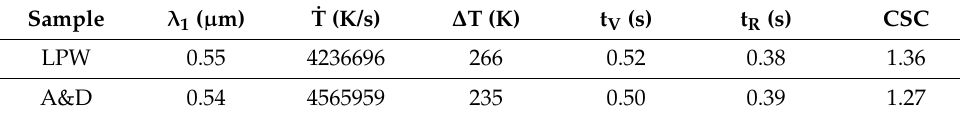
Figure 14. Curves obtained following Clyne and Davies [33] criterion for LPW and A&D samples. Table 4. Calculated values of LPW and A&D samples for CSC calculation.